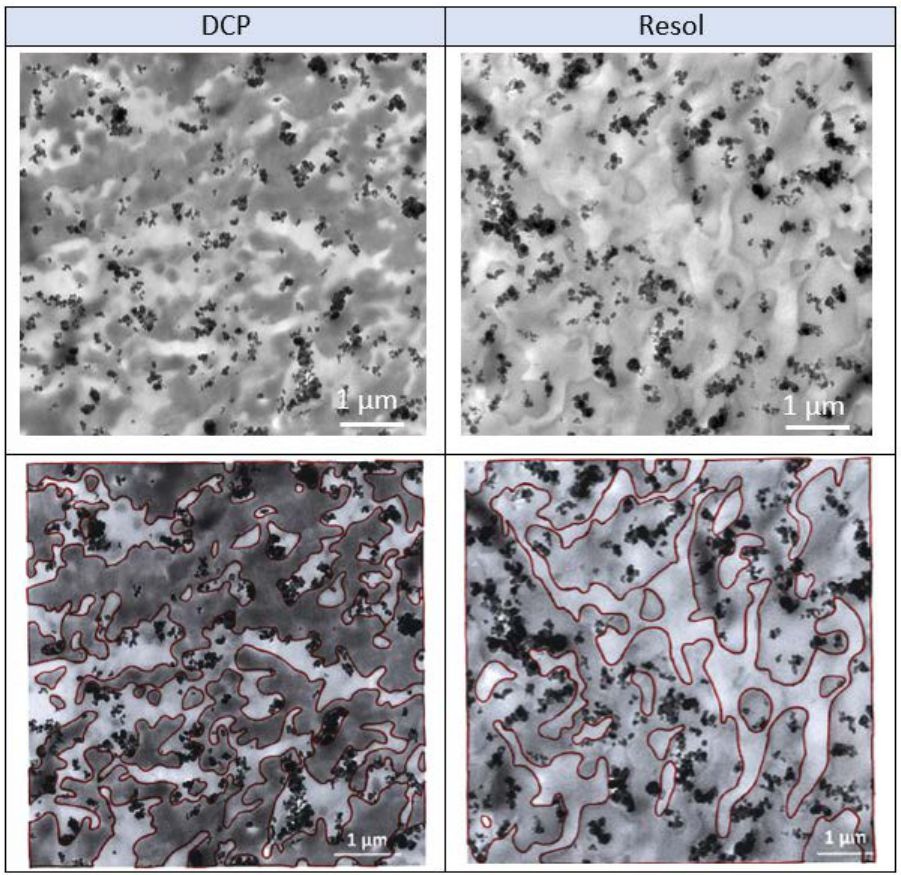
Figure 9. TEM pictures of filled TPV (PP: 75 phr) with 12 wt % of carbon black ( top ). Highlighting of phase limits ( bottom ) to help visualize the location of carbon black